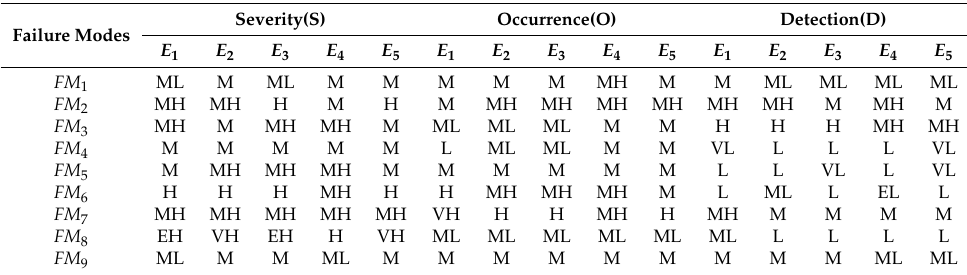
Table 4. Assessment information on the nine failure modes by FMEA team